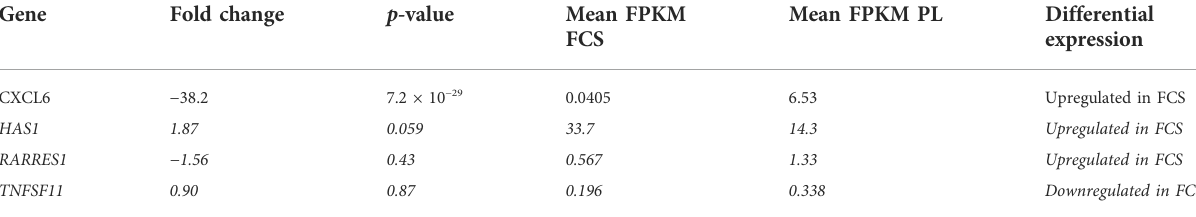
TABLE 4 overview of differential expression of genes reported to be downregulated in senescent MSC passages. Genes are designated by their gene name in the fi rst column. Fold change, p -value and FPKM for each gene are detailed in the columns. FPKM will be highest in the condition where the gene is upregulated. The direction of differential expression is shown in the last column. Genes considered not to be signi fi cantly up- or downregulated ( p > 0.05 and/or FPKM < 0.3) are marked in italic. (Gene list from Wagner et al., 2008). Gene Fold